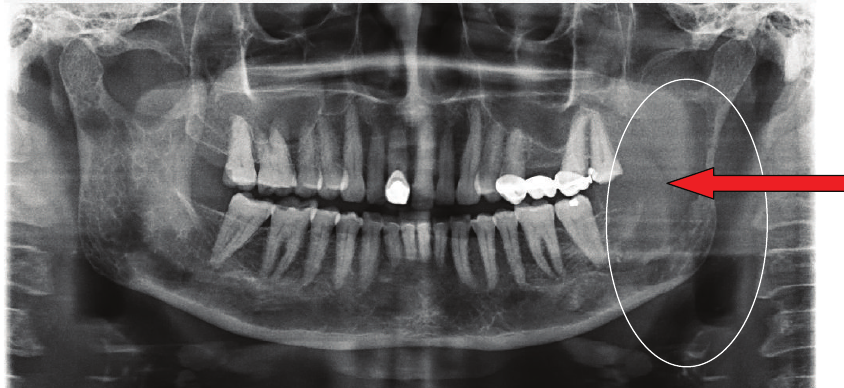
Figure 3: A radiolucent lesion with ill-defined ragged borders involving the left ramus, body, and coronoid process of the mandible. The right side of the mandible shows multiple punched out radiolucencies in the body, ramus, and condylar region with altered trabecular pattern.